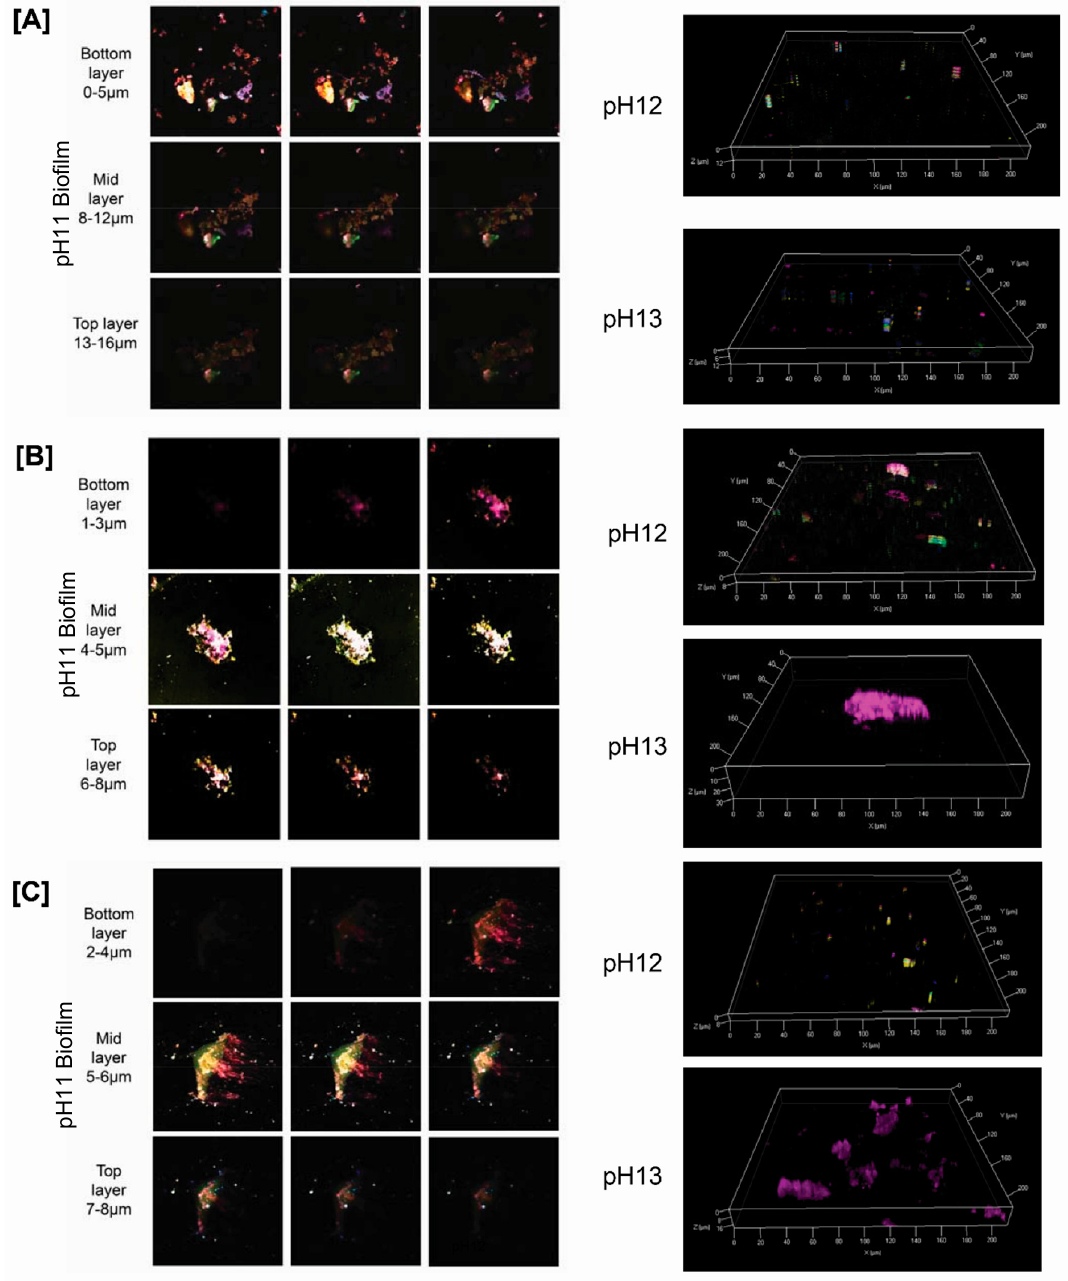
Figure 5. CLSM imaging of surface associated EPS components. ( A ) 16 µm thick biofilm grew on the surface of graphite ( A ) at pH 11, with an even dispersal of organic components sorbing to the surface at pH 12 and 13. eDNA composed a basal layer of biofilm at pH 11 on the surface of both 304L ( B ) and 316L ( C ) stainless steel surfaces and could be seen to have an affinity to the surface at pH 13 despite no obvious biofilm.